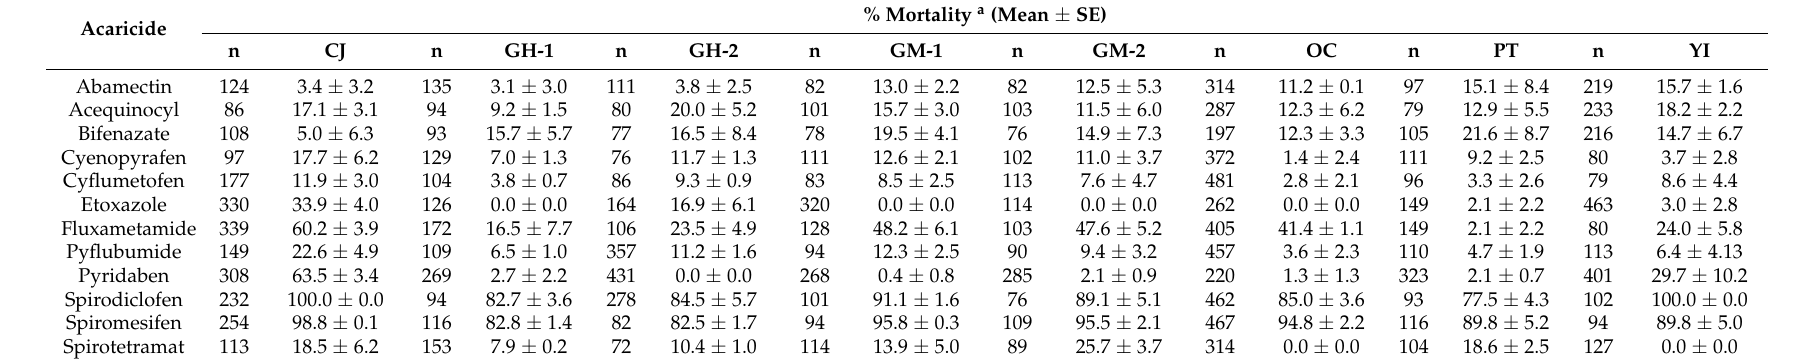
Table 6. Mortality of T. urticae eggs of eight field populations in response to 12 acaricides.